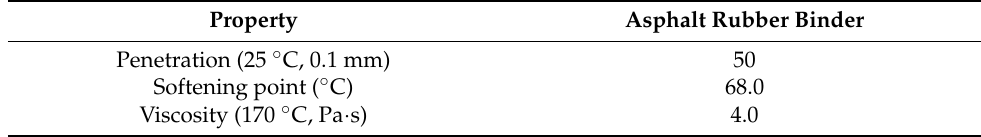
Table 5. Physical property of industrial asphalt rubber binder.